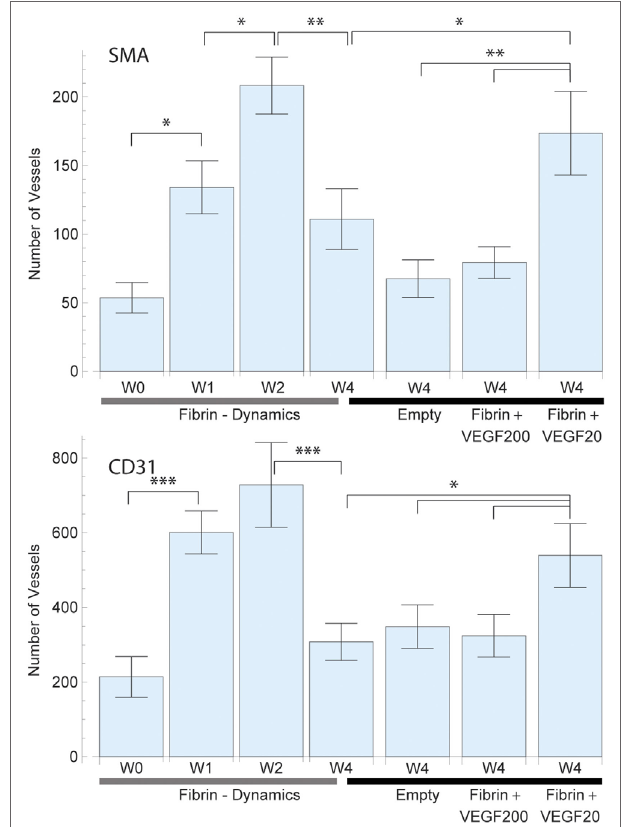
FIGURe 3 | Average total vessel count per sample in each of the study groups for smooth muscle actin (SMA) (top) and CD31 (bottom) staining. The left 4 bars indicate the vascular growth in pure fibrin over a period of 4 weeks. A constant increase in vascularization was observed up to week 2, followed by vascular resorption. The right 4 bars indicate the effect of high dose (200 ng) and low dose (20 ng) recombinant human vascular endothelial growth factor (rhVEGF165) in a fibrin matrix in comparison to pure fibrin and no matrix. A statistical significant difference between the high and low dose rhVEGF165 group was detected. 20 ng rhVEGF165 yielded the best results, while 200 ng was comparable to the empty control.